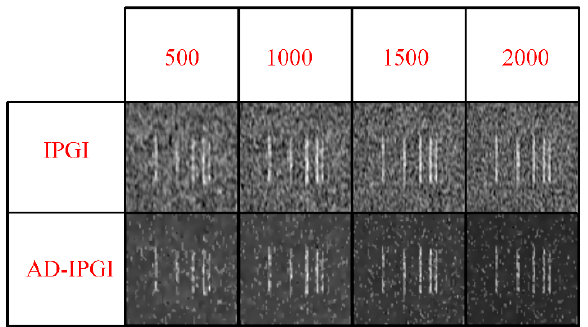
Figure 6. Experimental results for the imaging object “Slits” obtained by the IPGI and AD-IPGI imaging processes, with 500, 1000, 1500 and 2000 measurements.